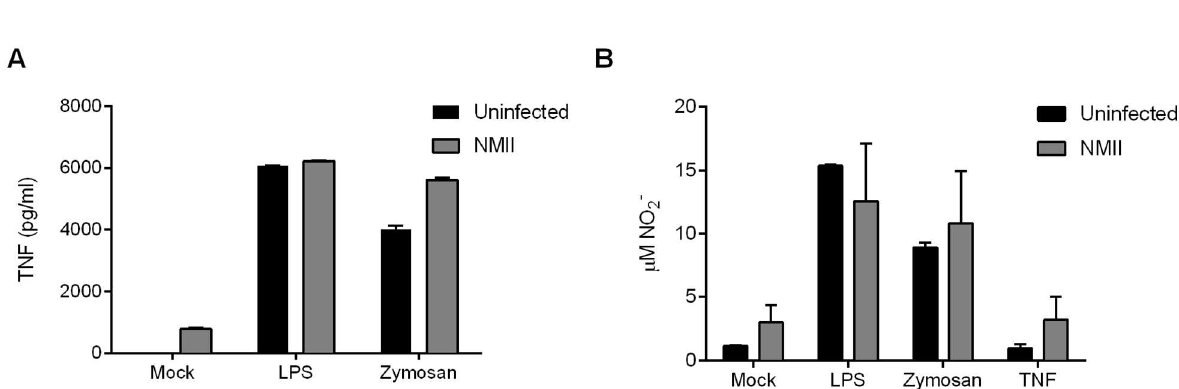
Fig 4. NMII-infected C57BL/6J BMDM produce moderate amounts of TNF and nitric oxide. BMDM were infected with NMII at an MOI of 50. At 8 h post-infection, cells were mock treated or treated with 100 ng/ml LPS (TLR4 ligand),10 μ g/ml zymosan (TLR2 ligand),or 10 ng/ml TNF (nitrite assay only). Followingan 18 h treatment, culture supernatantswere assayed for TNF by using an ELISA kit (A) and nitric oxide by determining nitrite concentration with the Griess reagent (B). Results are expressedas the means of three biological replicates from one experimentand are representative of two independent experiments. Error bars indicate the standarddeviations of the